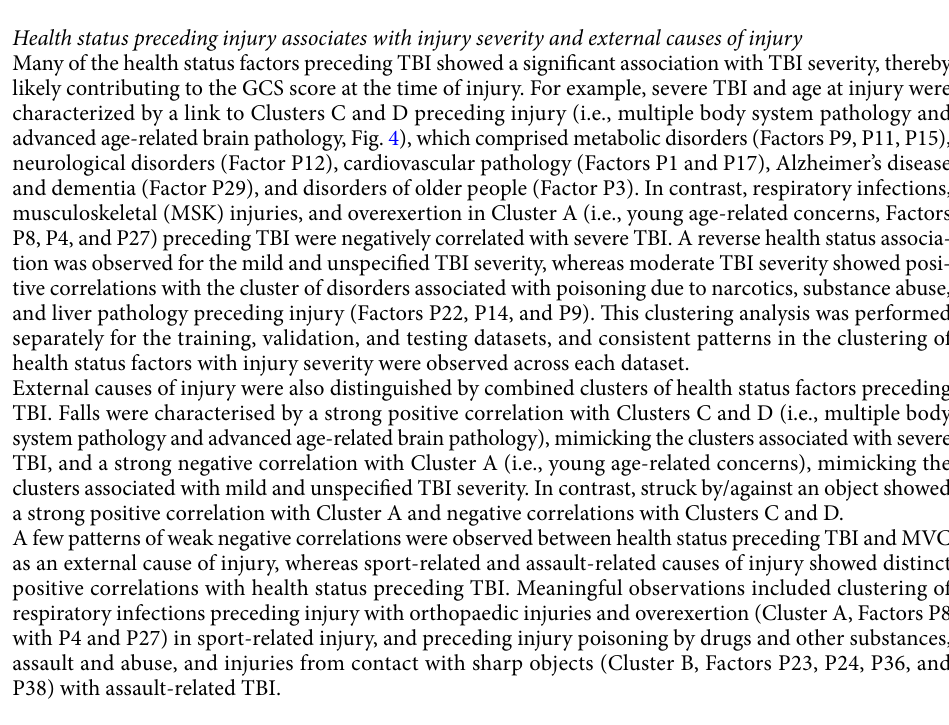
Figure 2. Health status factors at the TBI event phase by injury severity in patients with TBI in Ontario, Canada 2002–2016. The total number of each health status factor in TBI event across the sample set (n = 58,516). Data are shown for each injury severity, coloured by mild, moderate, severe, and unspecified. Abbreviations: ABX = antibiotics; Emerg= emergency; Resp=